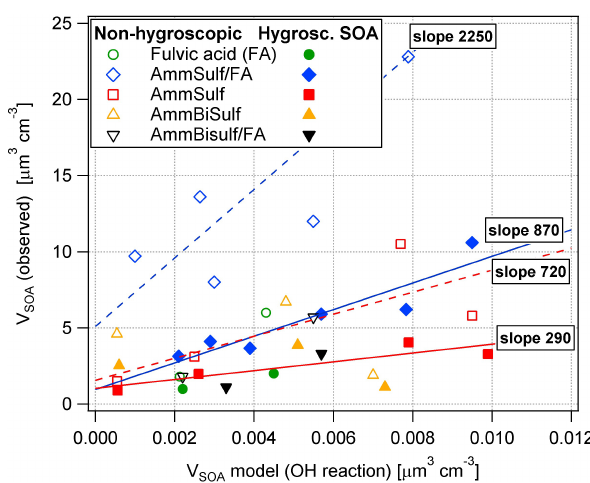
Fig. 4. Comparison of observed volume increase in photochemical experiments (Volkamer et al., 2009) and predicted volume increase due to the aqueous phase reaction of glyoxal and OH (Reaction R5, Table 2, Sect. 3.3.1 “Simulation A”) as previously applied to di- lute aqueous phase conditions (“cloud droplets”). Open symbols (non-hygroscopic SOA) imply that the observed volume increase was only due to SOA formation; filled symbols (hygroscopic SOA) refer to the assumption that observed volume increase is caused by formation of hygroscopic SOA and additional water uptake by this